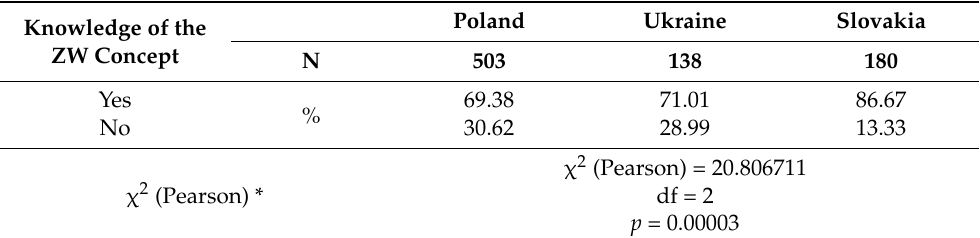
Table 4. Knowledge of the ZW concept among respondents from Poland, Ukraine and Slovakia. Knowledge of the